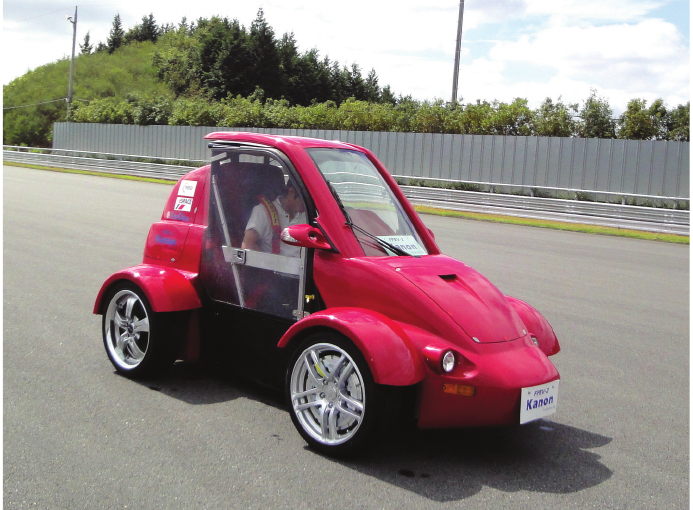
Figure 8. Experimental in-wheel motor-driven electric